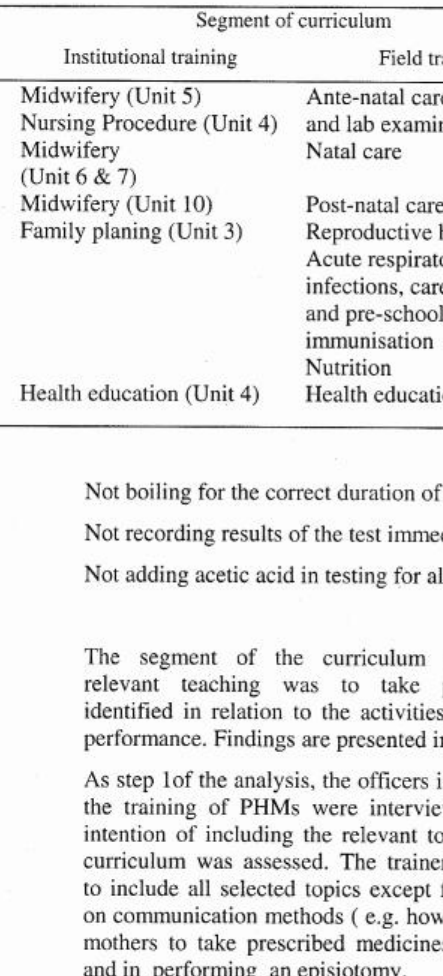
Table|. Distribution of number ofactivities with deficient performanceand corresponding segments of